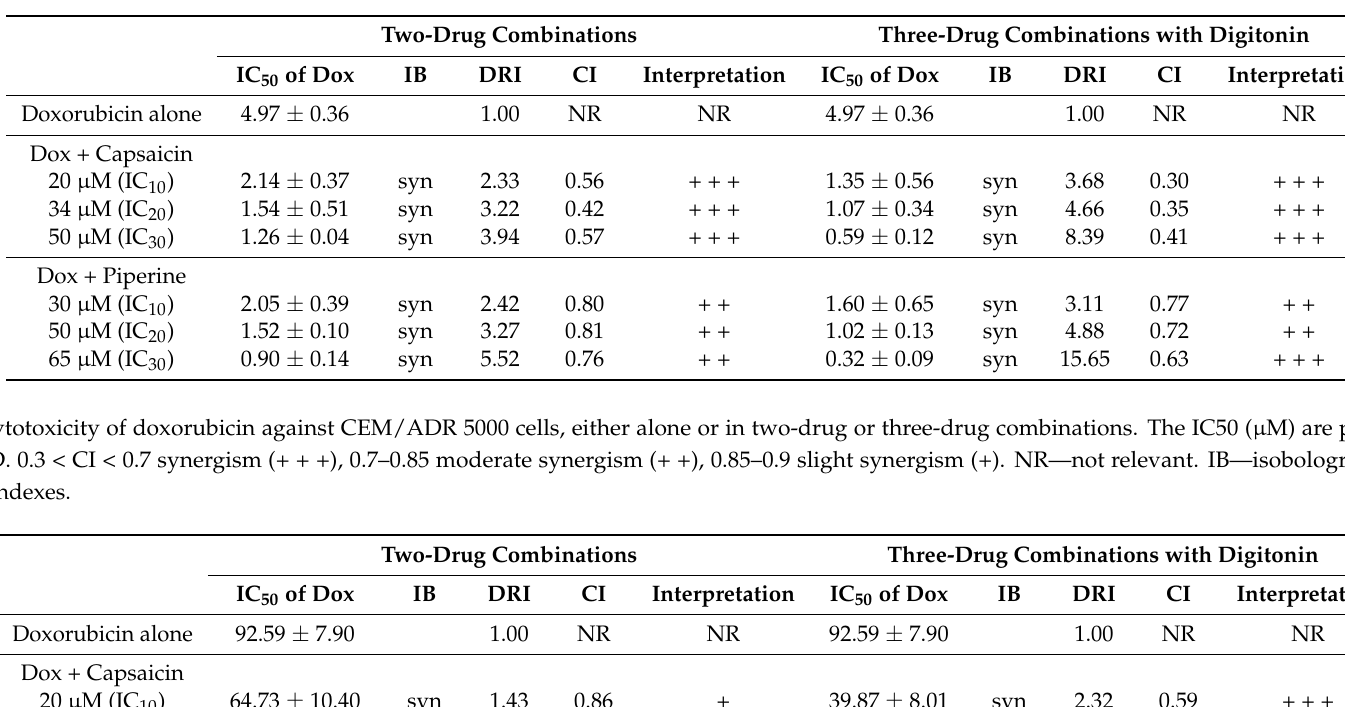
Table 2. Cytotoxicity of doxorubicin against Caco-2 cells, either alone or in two-drug or three-drug combinations. The IC 50 ( µ M) are presented as the mean ± SD. 0.3 < CI < 0.7 means synergism (+ + +), 0.7–0.85 moderate synergism (+ +). NR = not relevant. IB = isobologram. DRI = dose reduction indexes.